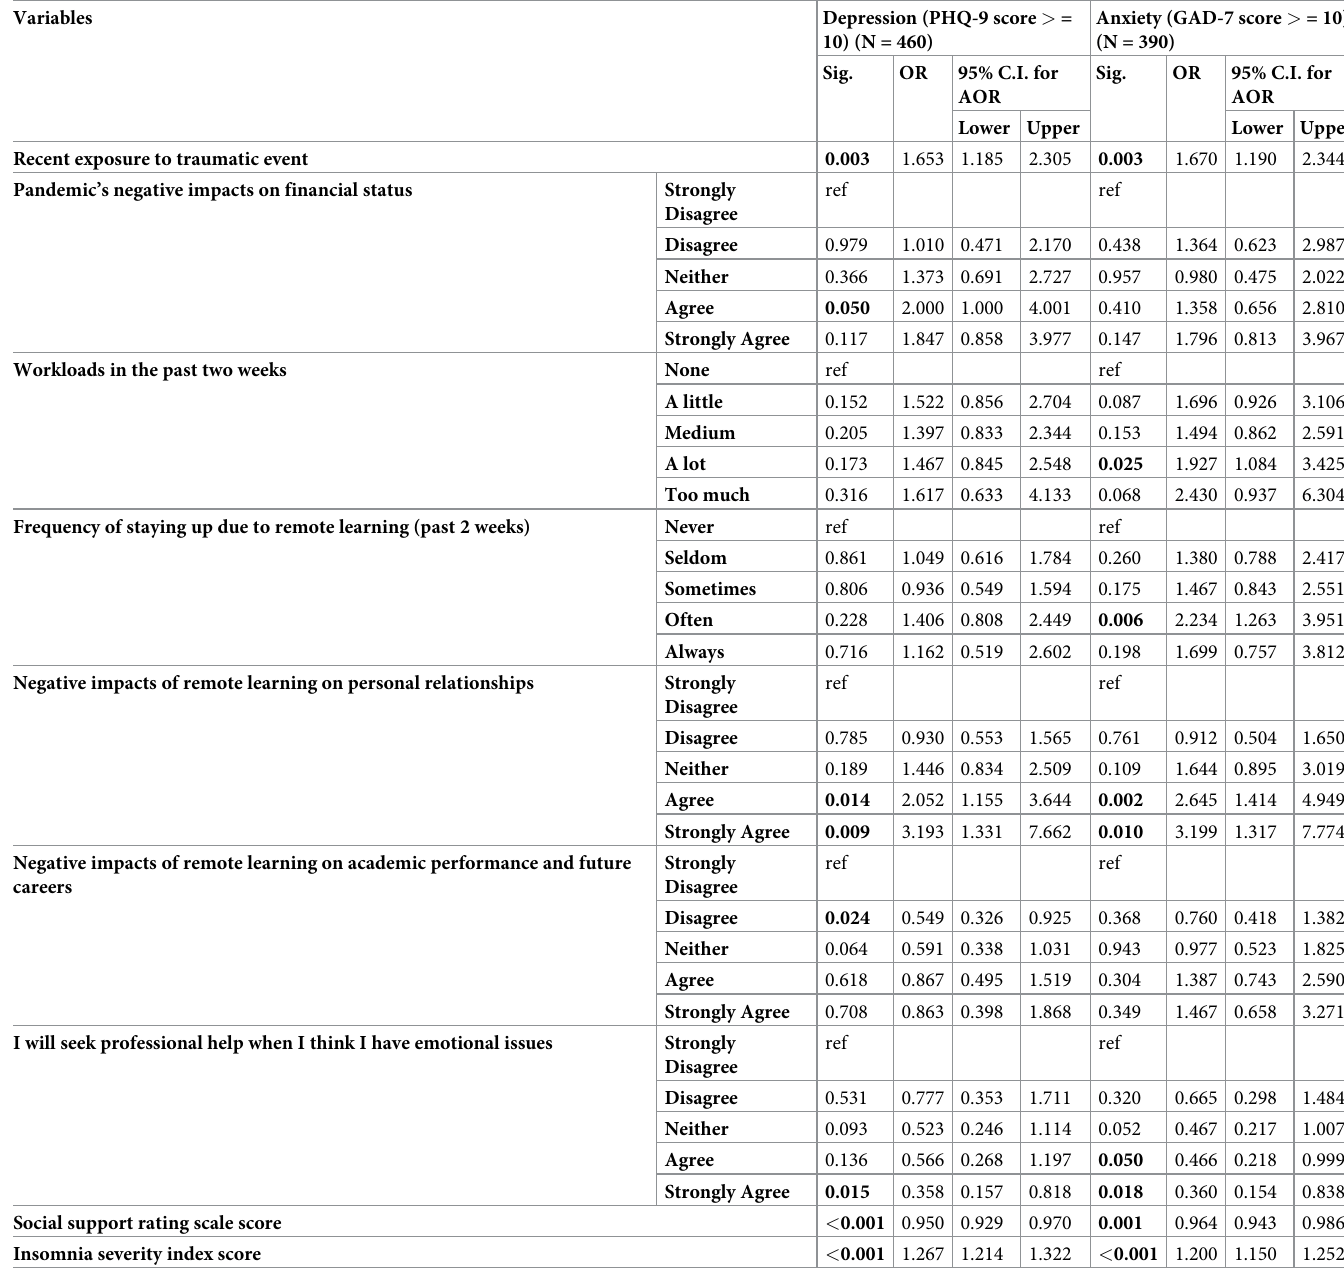
Table 2. Independent correlates of depression and anxiety by multivariable logistic regression analysis. The analysis for depression was adjusted for the area of study, current location, family relationships, source of tuition, and age; the analysis for anxiety was adjusted for the area of study, family relationships, source of tuition, and age. The frequency of US social media use, frequency of exercise in the past two weeks, and amount of knowledge about common mental disorders were not significantly asso- ciated with either the risk of depression or the risk of anxiety and were removed from the table for abbreviation purposes.